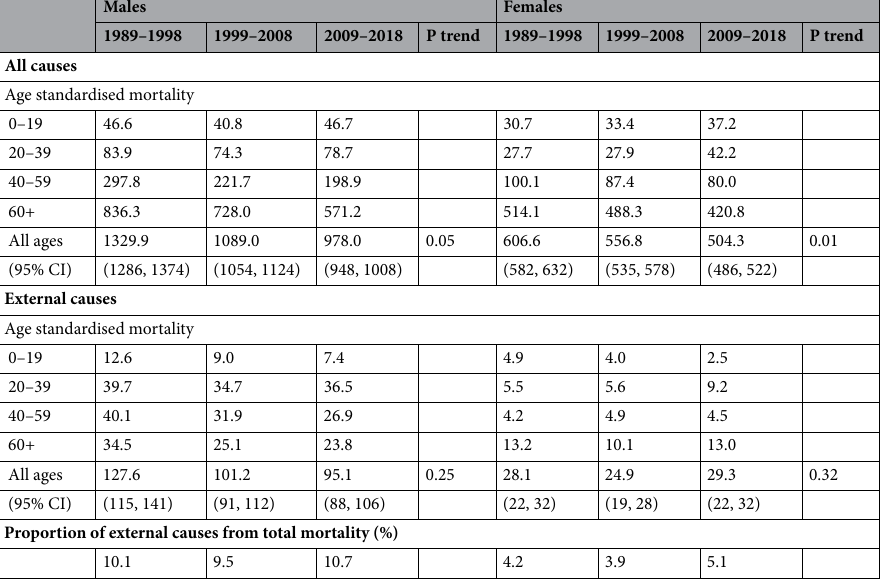
Table 3. Distribution of the population, age-adjusted all-cause mortality, and mortality due to external causes according to sex and age in 1989–1998, 1999–2008 and 2009–2018. All mortality rates are expressed per 100,000